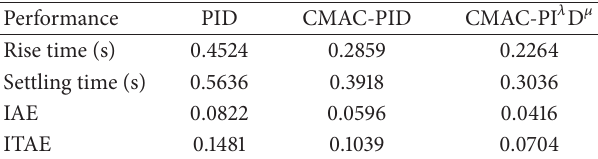
Table 1: Comparisons of